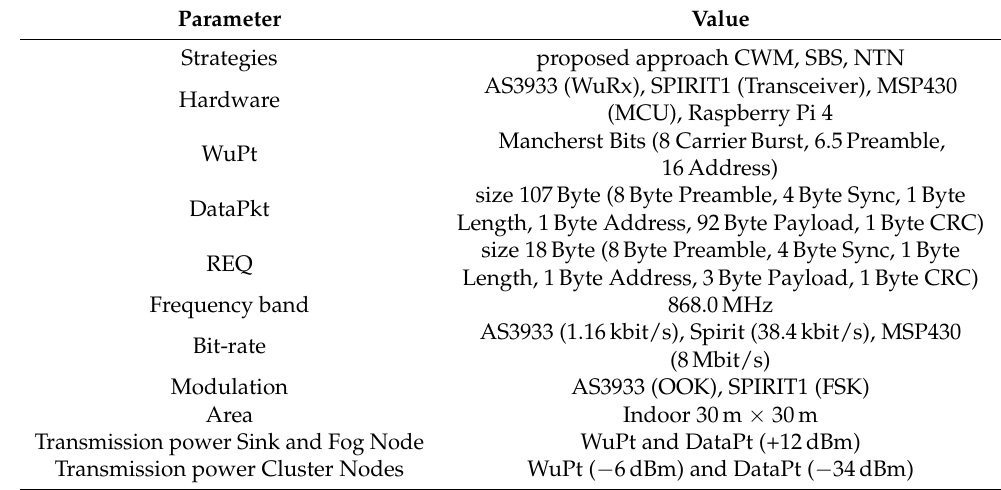
Table 1. Parameter values used in this experimental